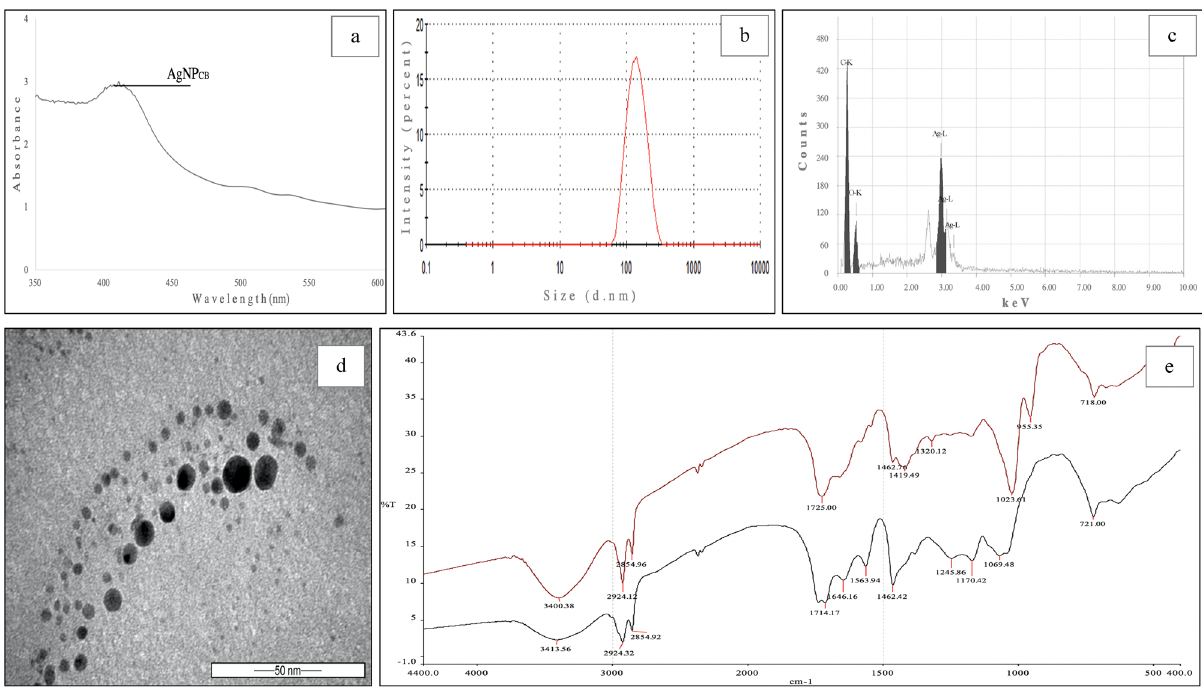
Figure 2: Characterization of biosynthesized AgNP CB by: ( a ) UV - vis spectroscopy, ( b ) DLS, ( c ) EDS of AgNP CB presenting 30% of Ag, ( d ) TEM imaging, and ( e ) FTIR of H. clathratus crude methanol extract before ( black ) and after AgNP CB synthesis ( red ) .